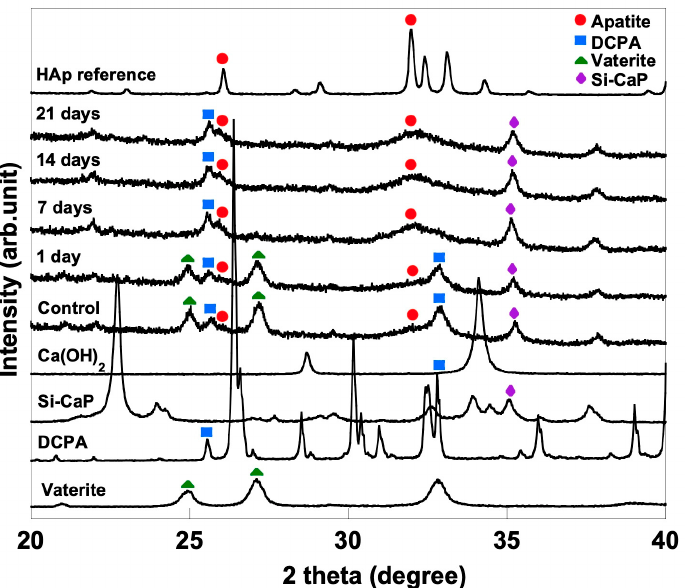
Figure 5. XRD patterns of CO 3 Ap- Si-CaP -Ca(OH) 2 set cement before and after soaking into SBF for 1, 7, 14, and 21